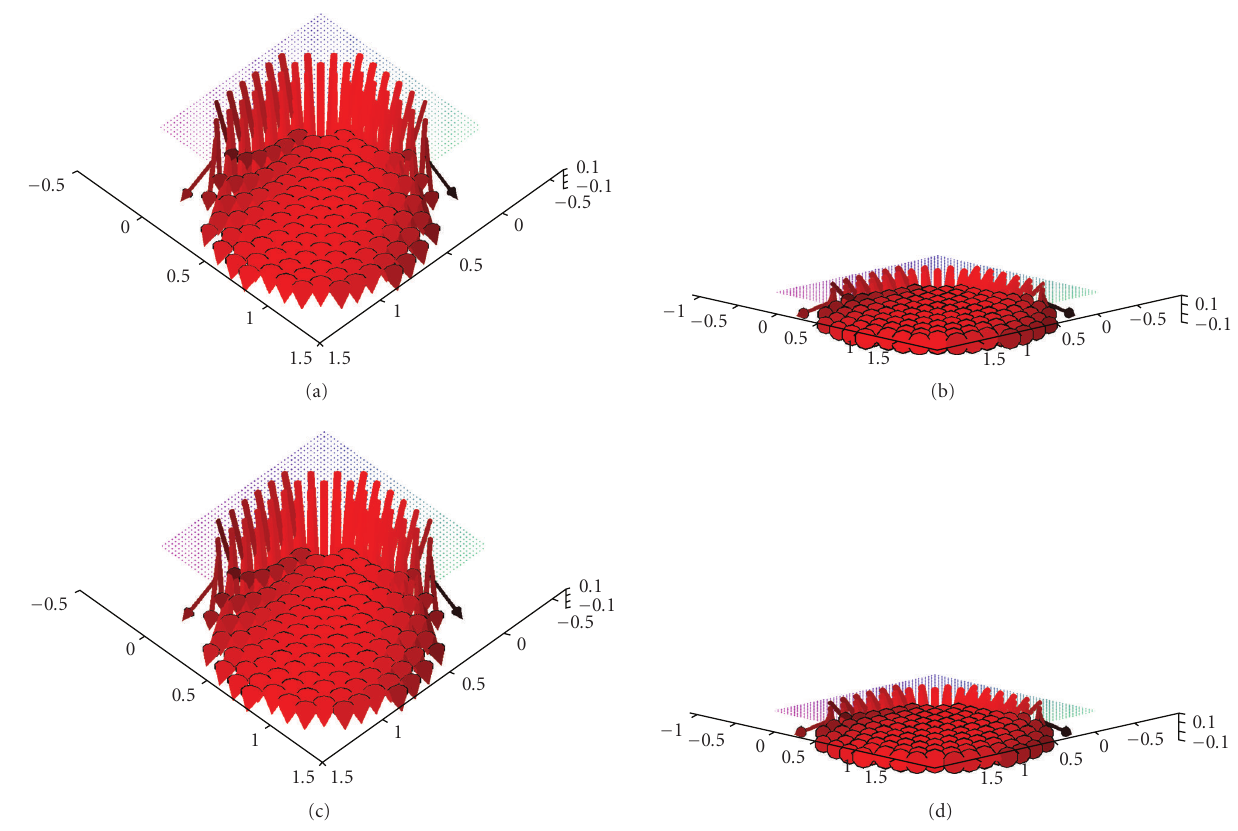
Figure 14: (a),(b) Reconstruction of the vector field f ( x ) = (1,1,1) (cid:9) with the described algorithm for γ = 0 . 007 in the plane { x 3 = 0 } . (c),(d) Reconstruction of the vector field f ( x ) = (1,1, − 1) (cid:9) with the described algorithm for γ = 0 . 007 in the plane { x 3 = 0 }